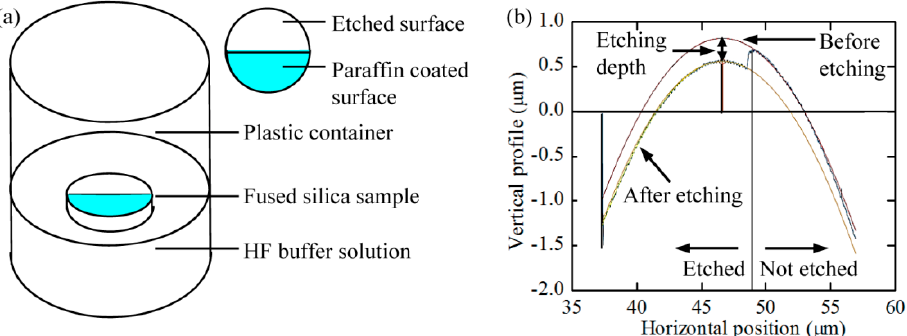
Figure 3. Sketch of the HF acid etching experiment ( a ) and the principle diagram; ( b ) for determining the etching depth using stylus profilometer in the etching process of fused silica optics.